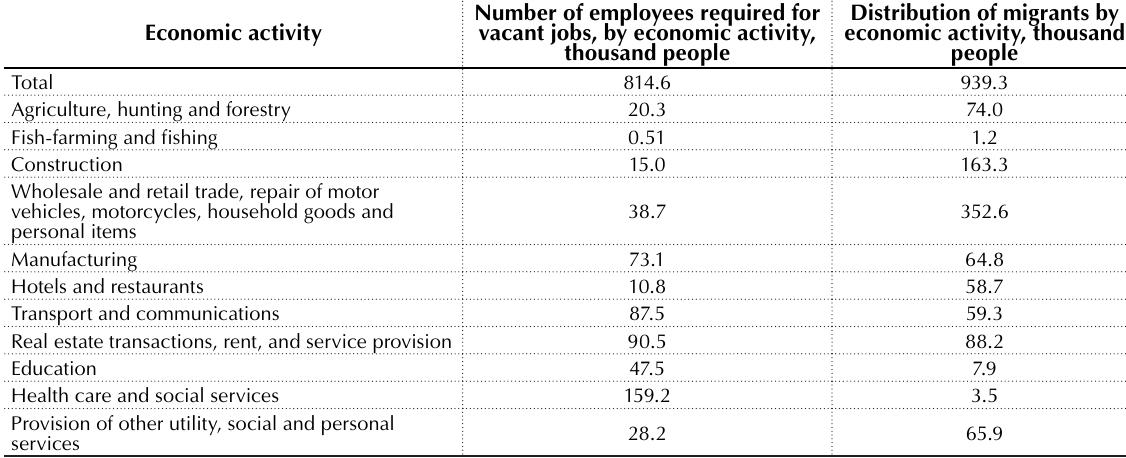
Table 5. Number of employees required for vacant jobs and the distribution of migrants by economic